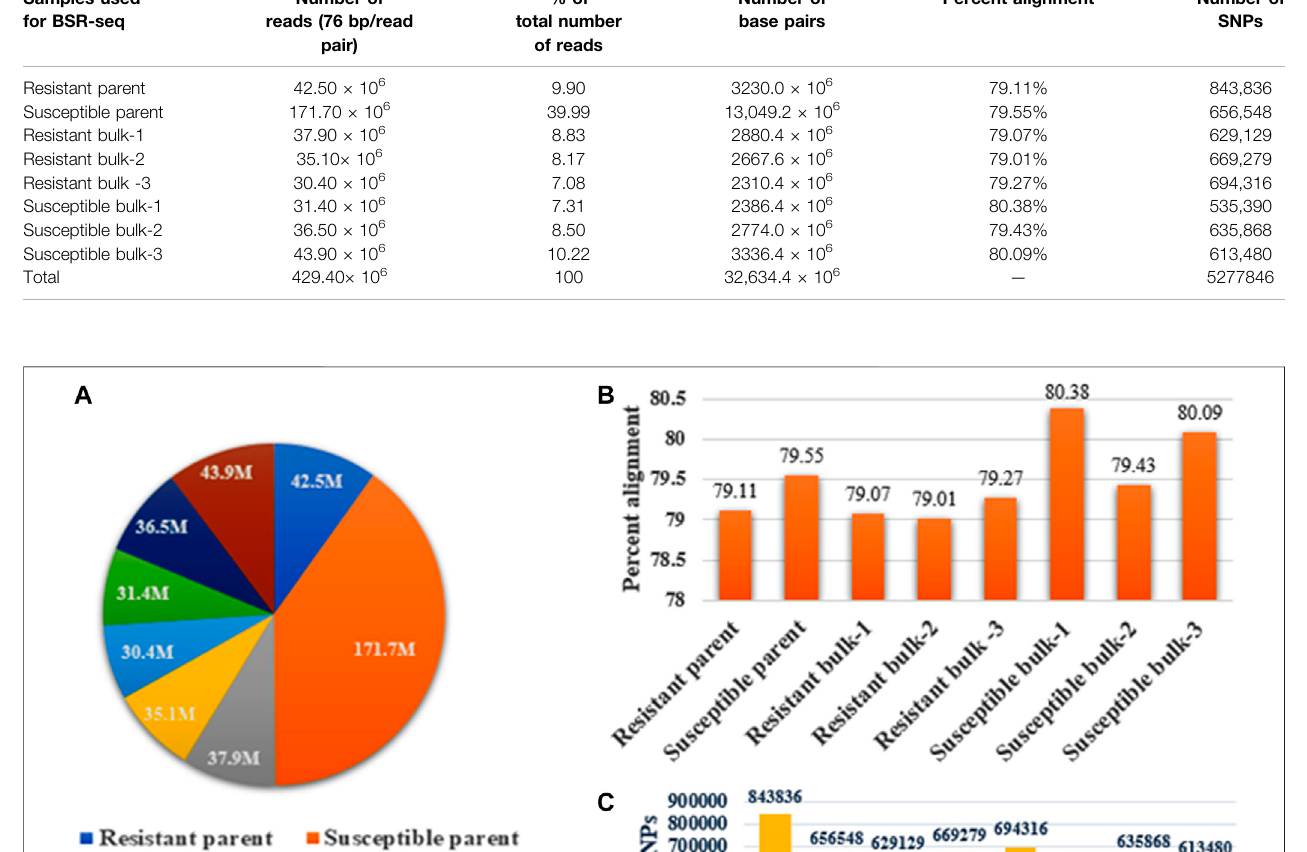
TABLE 2 | Number of reads generated, alignment percentage, and number of SNPs in parents, resistant bulk, and susceptible bulk of the “ YS#24 × YS#58 ” in wheat. Samples used for BSR-seq